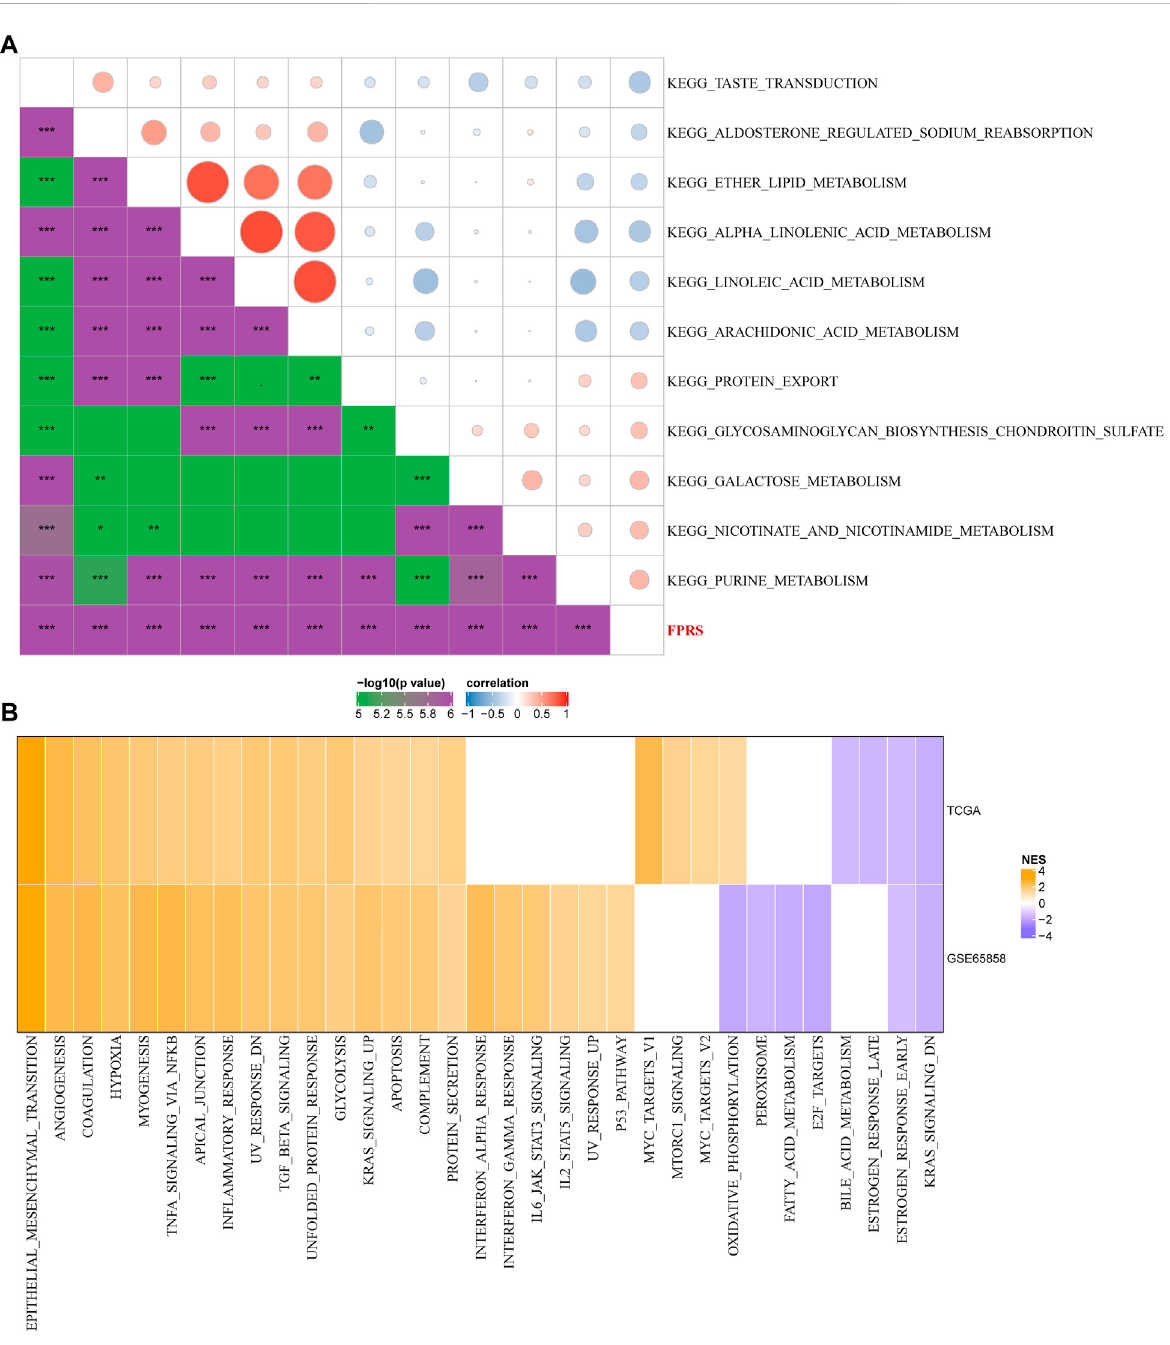
FIGURE 9 Path characteristics betweenFPRS packets. (A) Correlation analysis results between KEGGpathwayswith FPRS correlation greaterthan 0.3and FPRS; (B) a heatmap demonstrating normalized enrichment scores (NESs) of Hallmark pathways calculated by comparing FPRS-high with FPRS-low (with a false discovery rate (FDR) of <